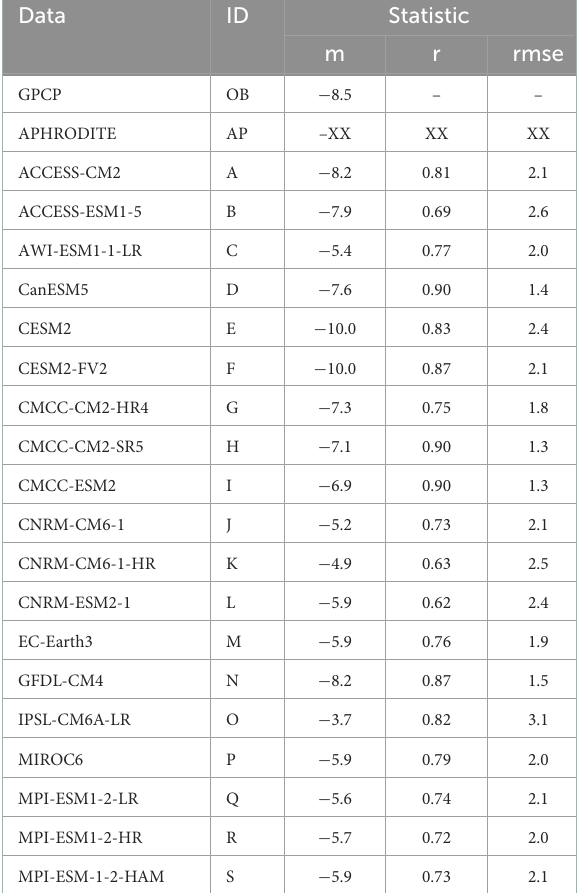
TABLE 2 Statistics of observed and simulated rainfall anomalies over the study domain. Data ID Statistic